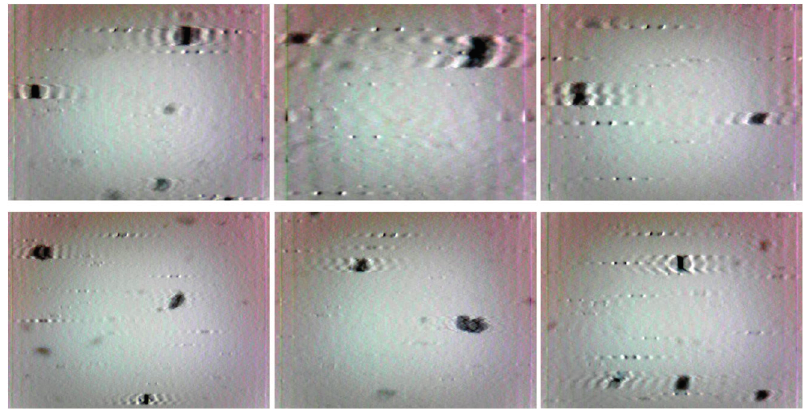
Figure 10. Six input particle images.